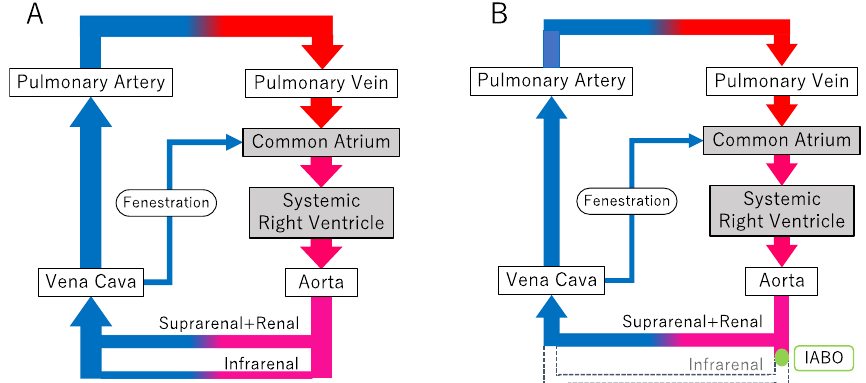
Fig. 1 Circulatory flow in the current Fontan-palliated patient A without infrarenal IABO and B with IABO. A Venous blood flows back directly to the pulmonary artery without passing through the atrium and ventricle. B When infrarenal IABO is applied, cardiac output is assumed to be reduced. IABO, intra-aortic balloon